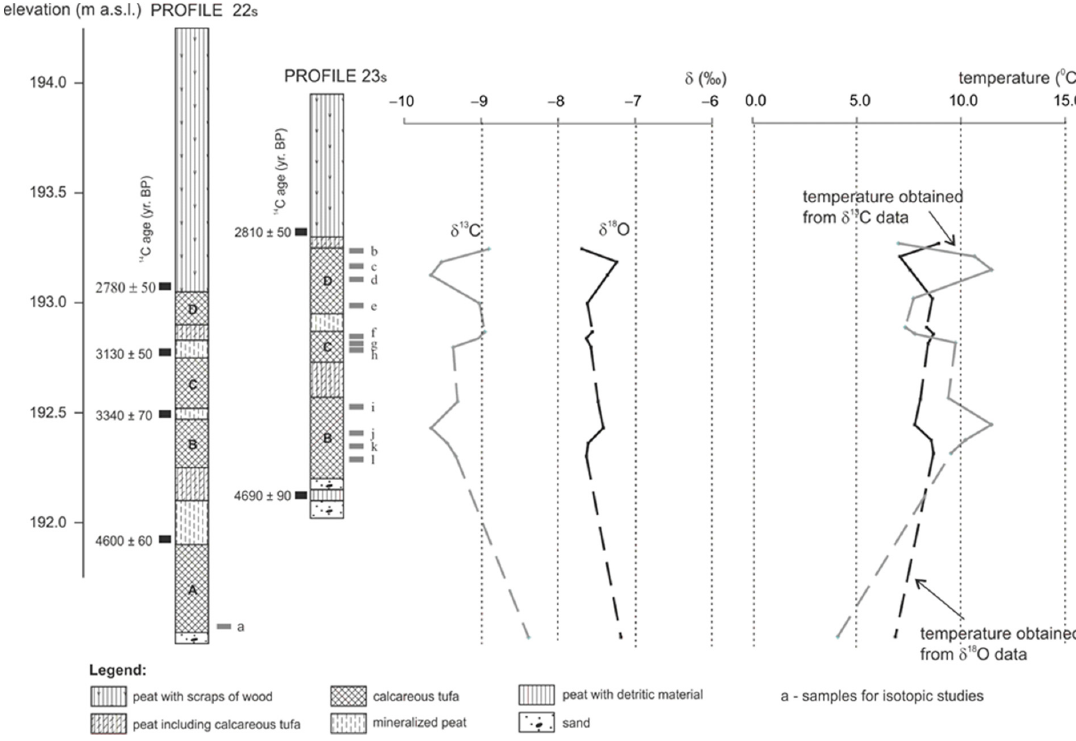
Figure 4. Determinations of stable isotopes of oxygen and carbon in calcite and temperatures obtained on their basis.